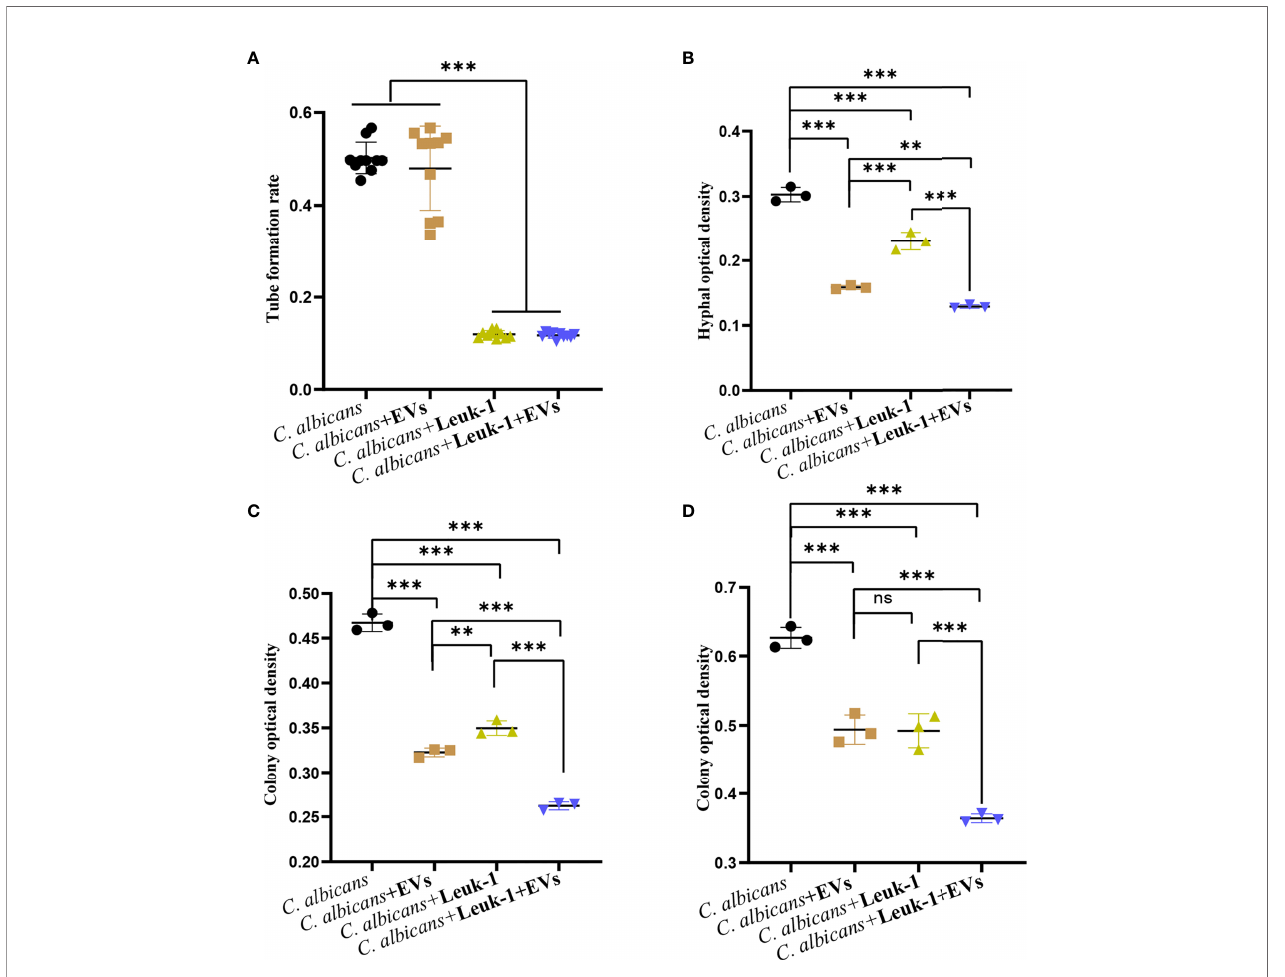
FIGURE 7 | Inhibition of C. albicans growth by a combination of Leuk-1-EVs and Leuk-1 cells. (A) Changes in the germ tubes of different groups at 2 h (n = 10). (B) Changes in the hyphal percentages of different groups at 12 h (n = 3). (C) Changes in the microcolony optical densities of different groups at 24 h (n = 3). (D) Changes in the microcolony optical densities of different groups at 48 h (n = 3). Statistical signi fi cance was tested by one-factor ANOVA. ns, not signi fi cant; **P < 0.01; ***P <